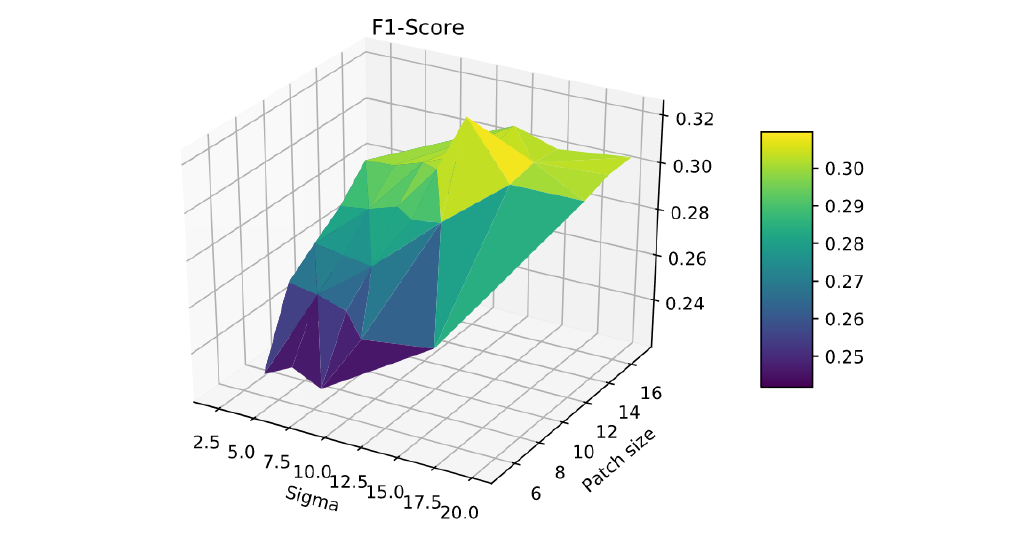
Figure 7. F1-Score as a function of the patch size and the value of sigma σ on patient